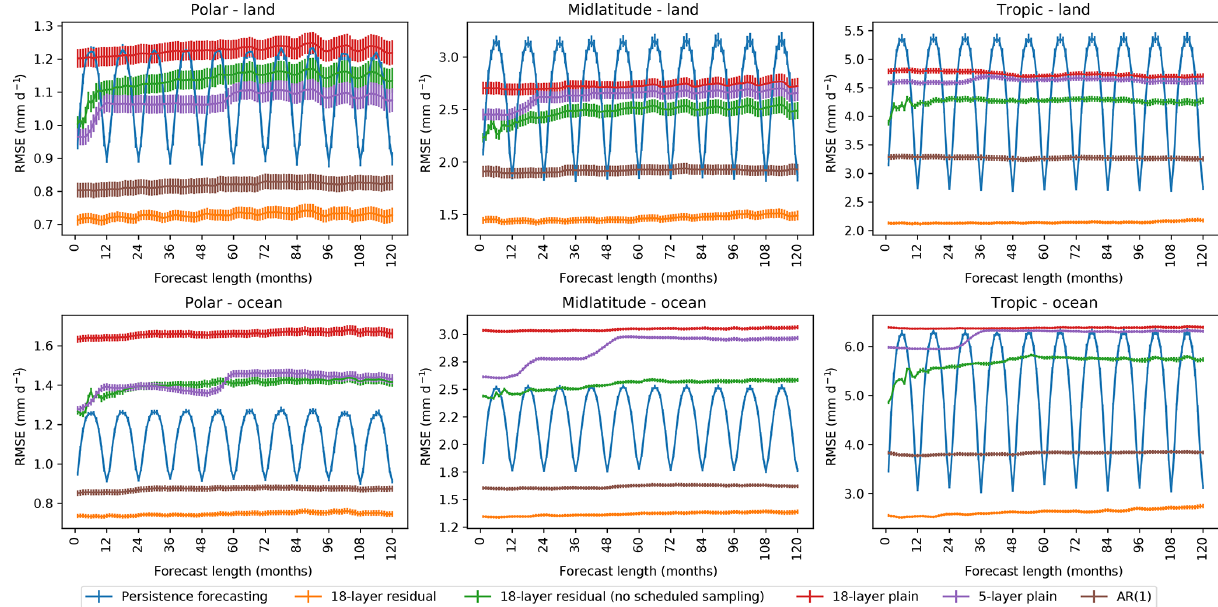
Figure 4. RMSE for decadal precipitation forecasts for six regions of interest. Both the plain and residual CNNs used a window size of 60. Vertical bars denote the standard error over all possible starting dates in the test set. The deep residual network with scheduled sampling outperforms all models in all regions and achieves consistent error over time. Removing any of these features from the network results in substantially lower performance.